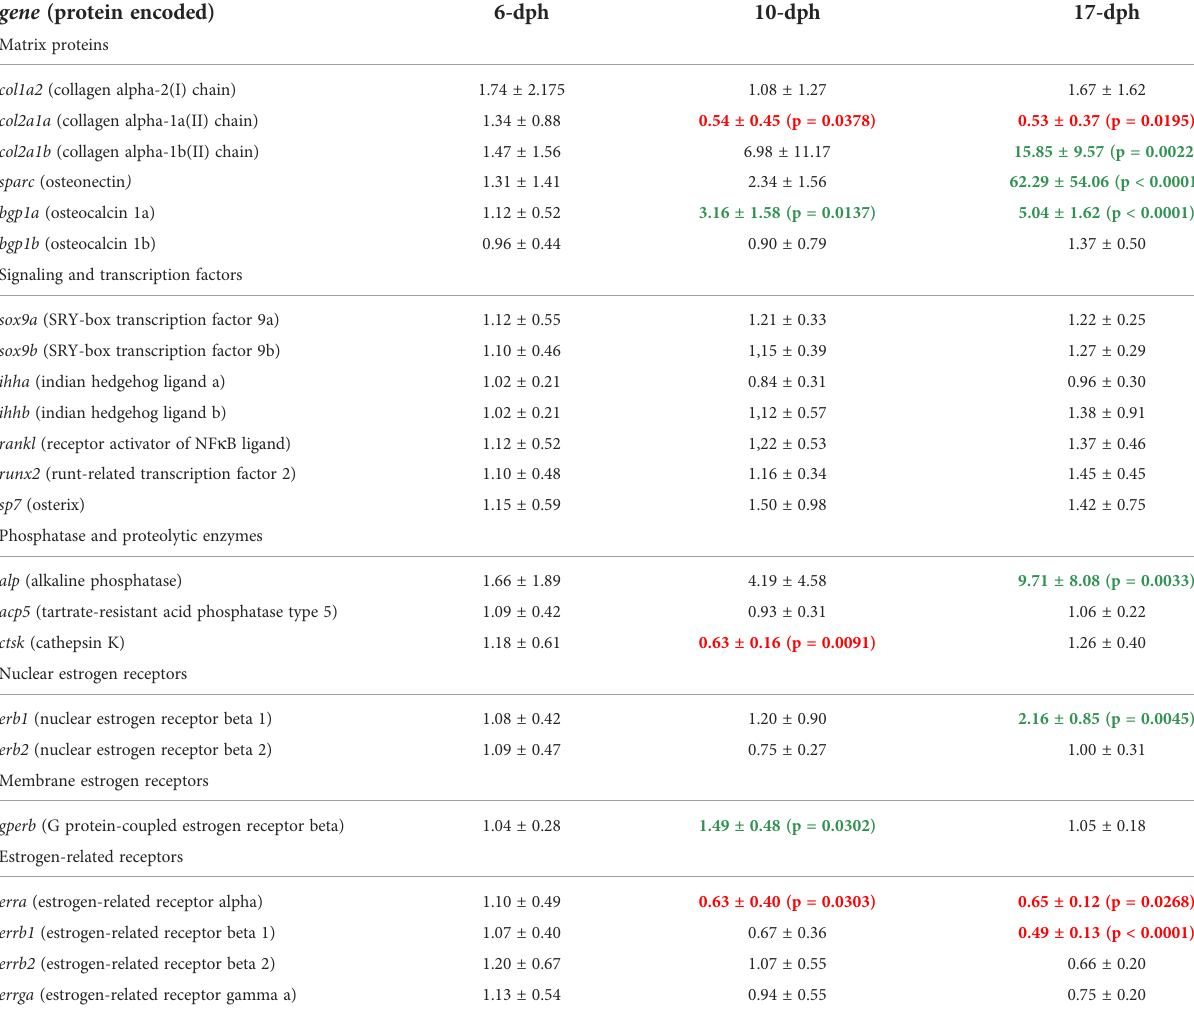
TABLE 2 Longitudinal analysis of mineralization-related genes and estrogenic endocrine control related genes mRNA expression according to developmental timing in 6-, 10- and 17-dph individuals maintained in control rearing conditions ( fi rst cohort). gene (protein